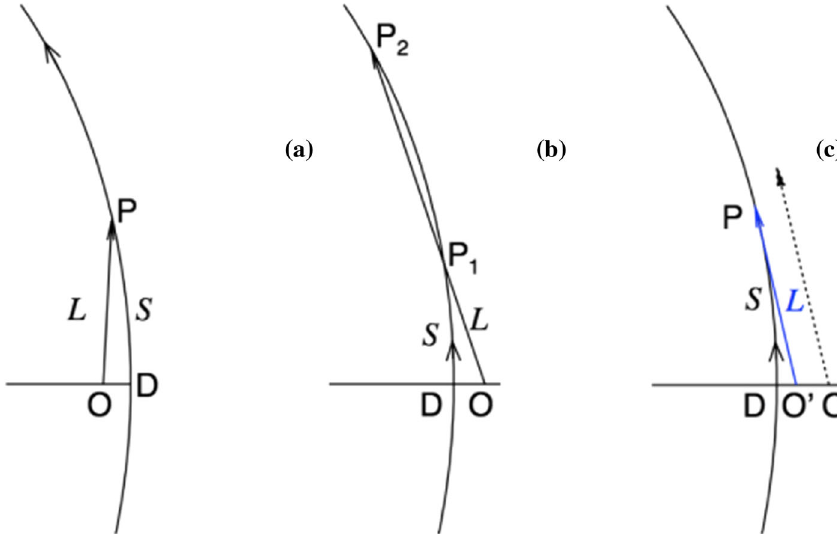
tion based on the original uncorrected momenta of jets or leptons from Z (improved momenta of jets from Z and the consideration of Eq. (4))